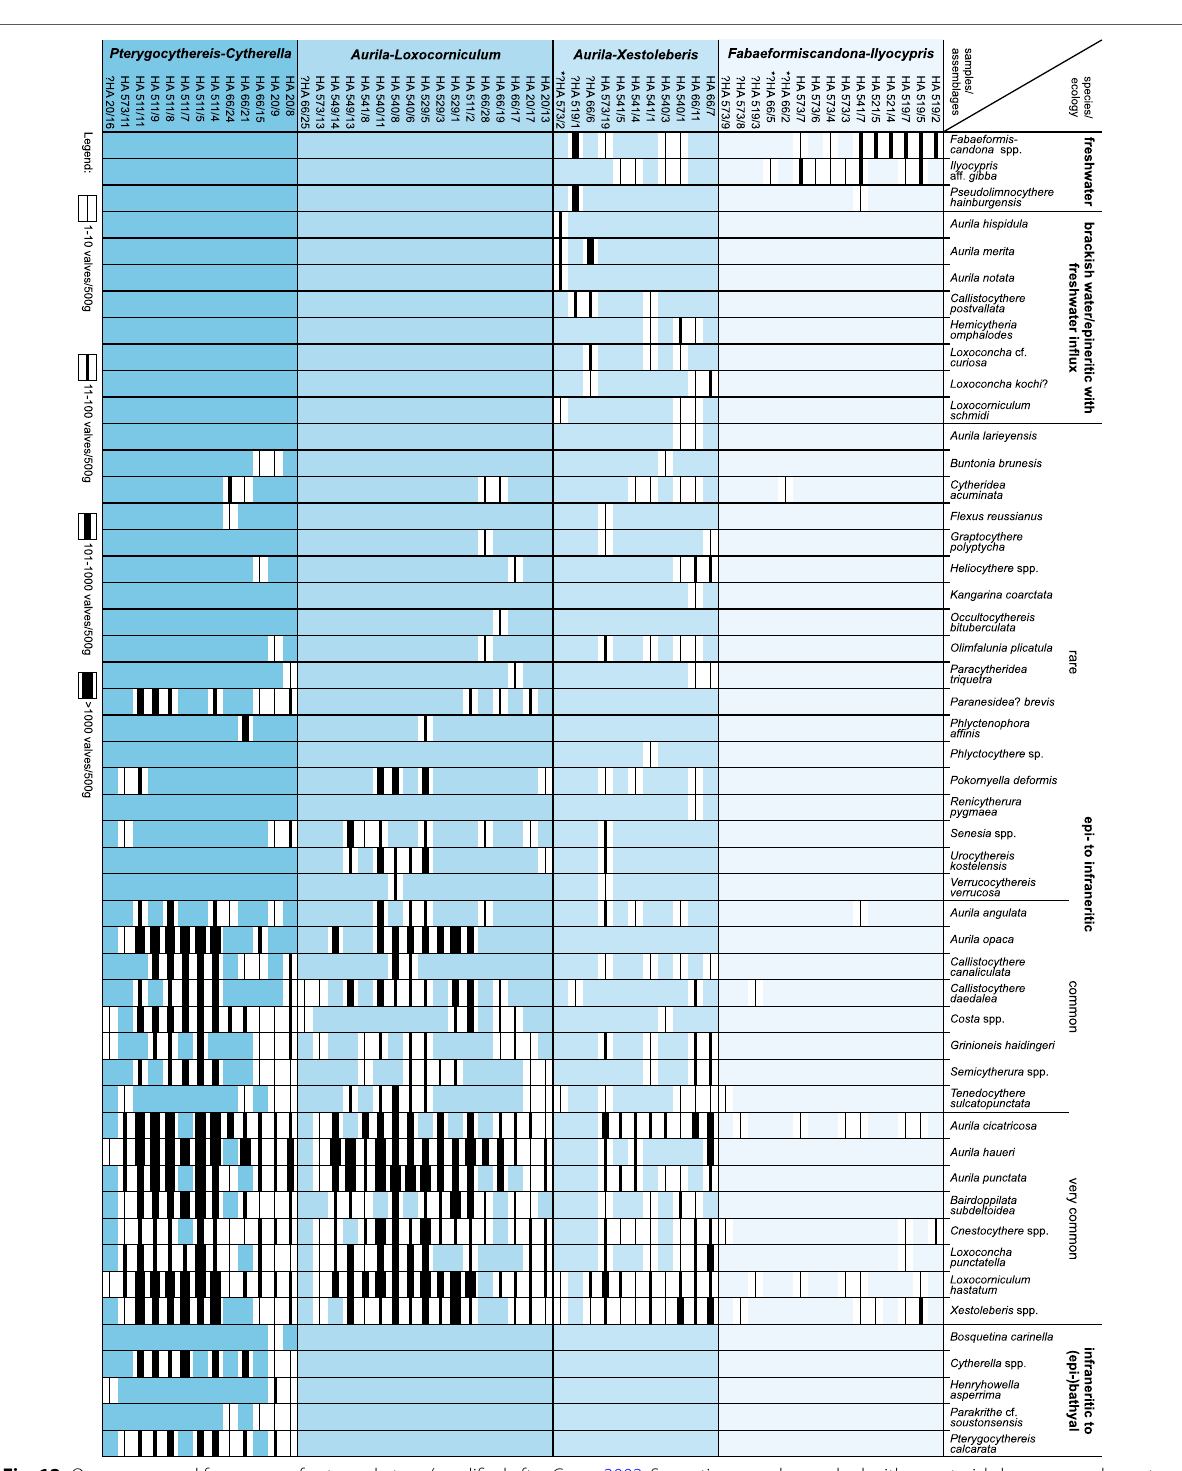
Fig. 12 Occurrence and frequency of ostracode taxa (modified after Gross, 2002; Sarmatian samples marked with an asterisk; barren samples not